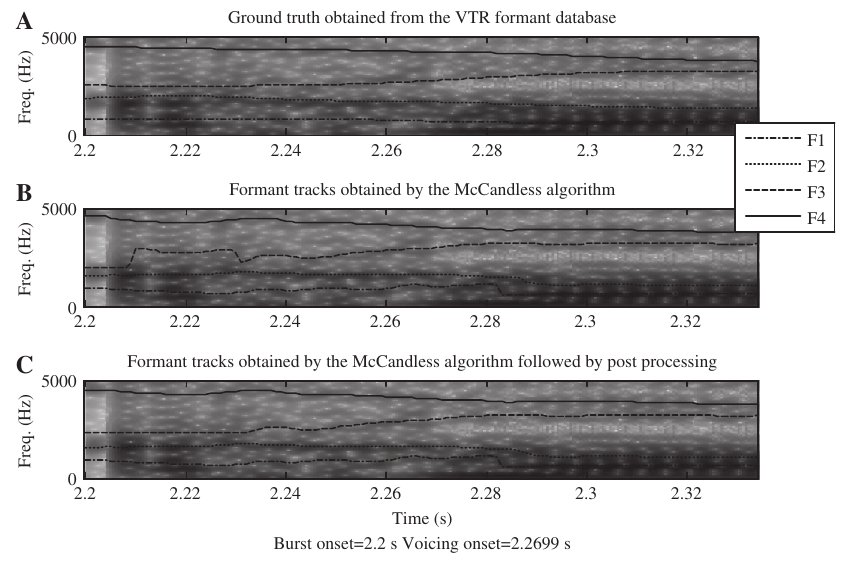
Figure 3. Ground Truth, Formant Tracks Obtained by Applying the McCandless Algorithm Before and After Postprocessing for the CV Syllable